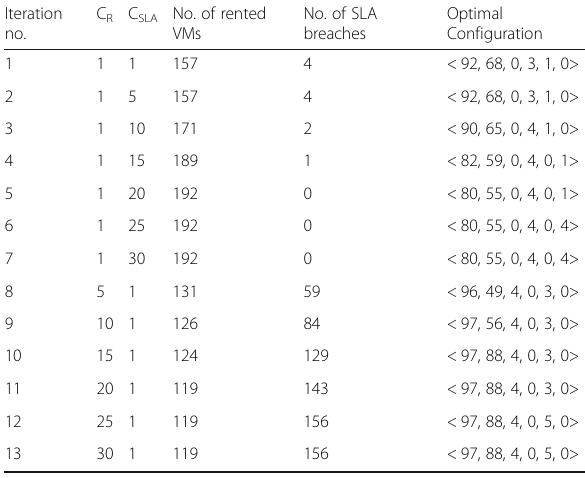
Table 17 The genetic algorithm behavior in an environment with the periodic